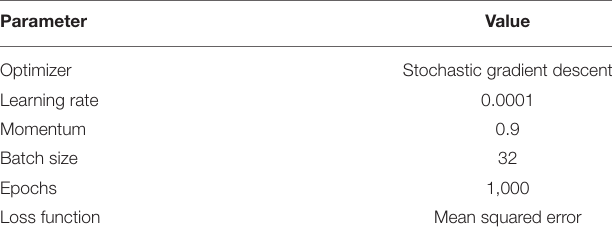
TABLE 2 | Training configuration of the used AlexNET. TABLE 3 | Training configuration of the CycleGAN with our proposed counterfactual loss